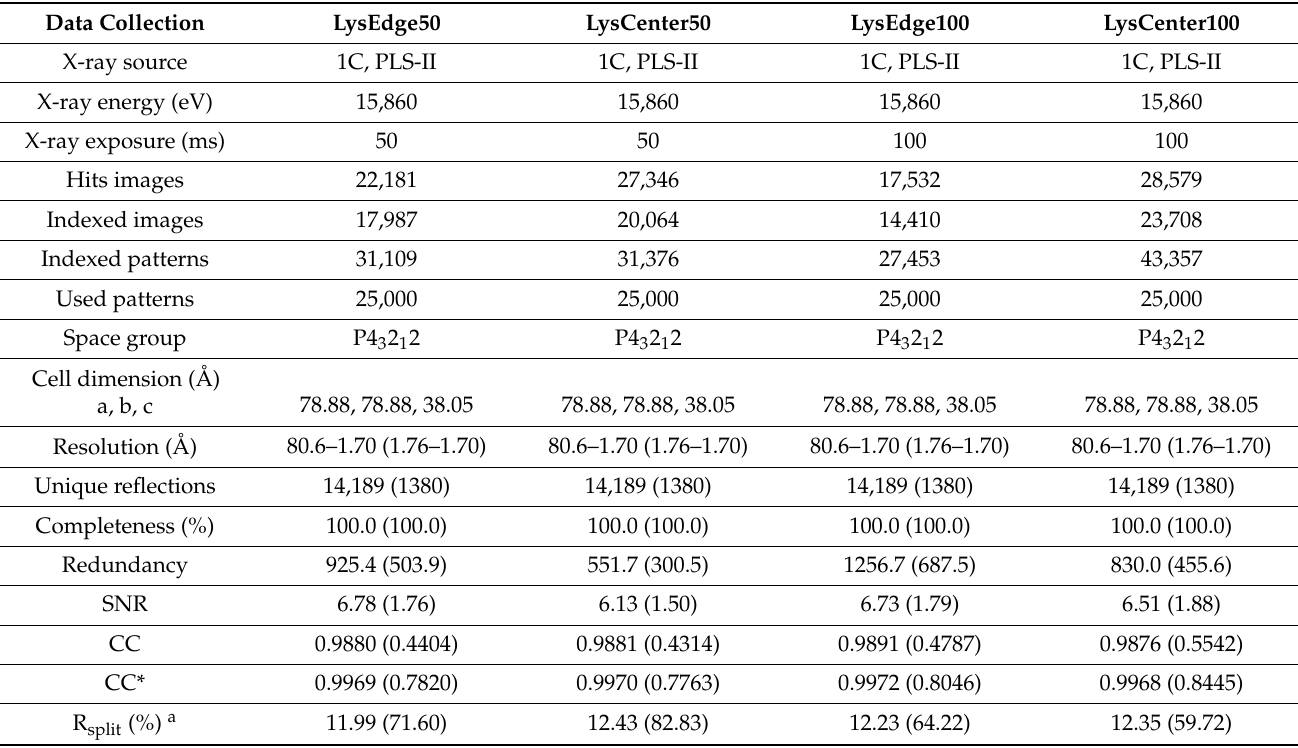
Table 1. Data collection